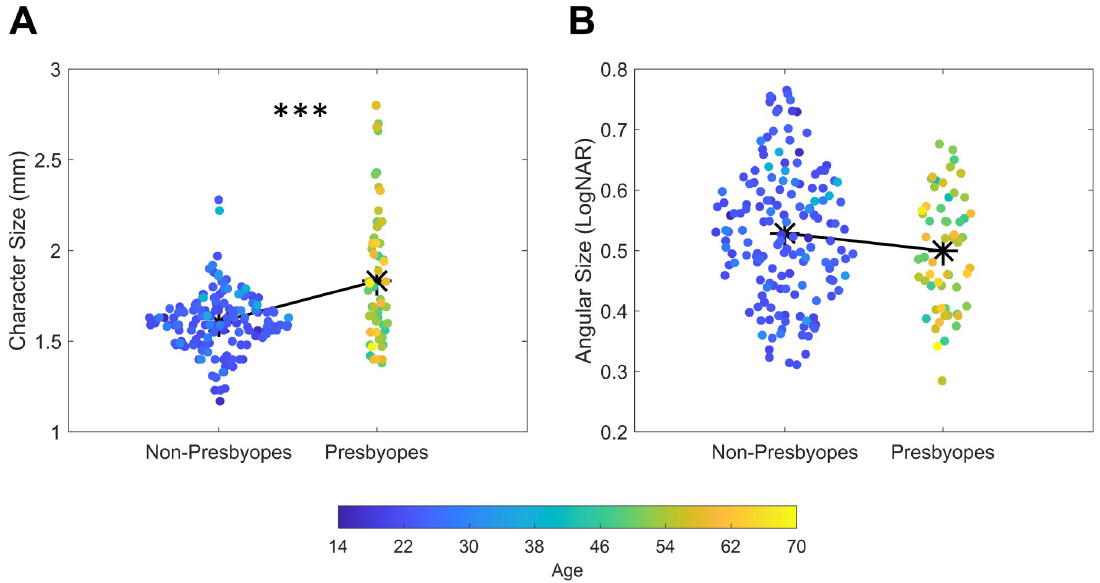
Fig 4. Scatterplot depicting values of character size (A) and angular size (B) for non-presbyopes and presbyopes. Asterisks depicts average values while different colors represent different ages ( ��� = p < 0.001). was not the case for character size which was found to follow NAVQ scores ( t 0.024) with participants with more difficulties in near vision adopting also larger character sizes (mean: 2.01 mm, std: 0.28 mm) as compared to participants with subthreshold scores (mean: 1.76 mm, std: 0.38 mm).